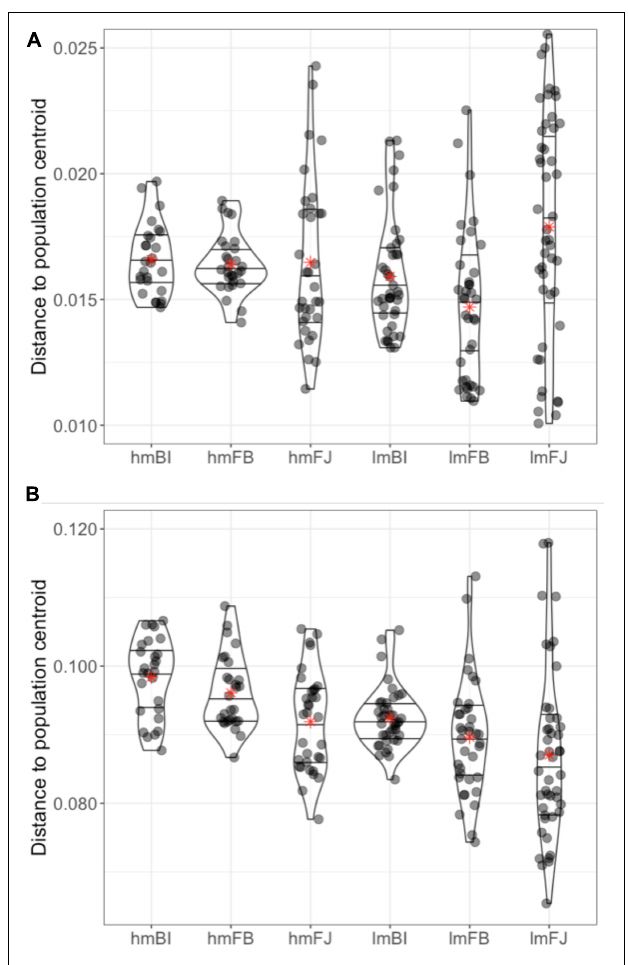
FIGURE 6 | Distance from each individual sample to its corresponding subpopulation centroid calculated using (A) genetic distance matrices and (B) epigenetic distance matrices for subpopulations (site × habitat). Lines within the violin plots represent the 25, 50, and 75% quartiles of the distribution and red asterisks denote the average distance to centroid for each subpopulation. Subpopulations are as follows: high and low marsh Bowens Island (hmBI, lmBI), Folly Beach (hmFB, lmFB), and Fort Johnson (hmFJ,